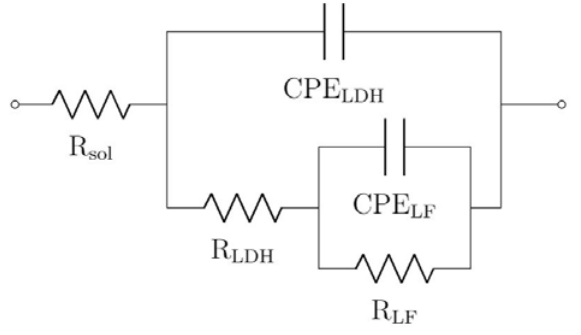
Figure 11. ECC used for curve fitting.